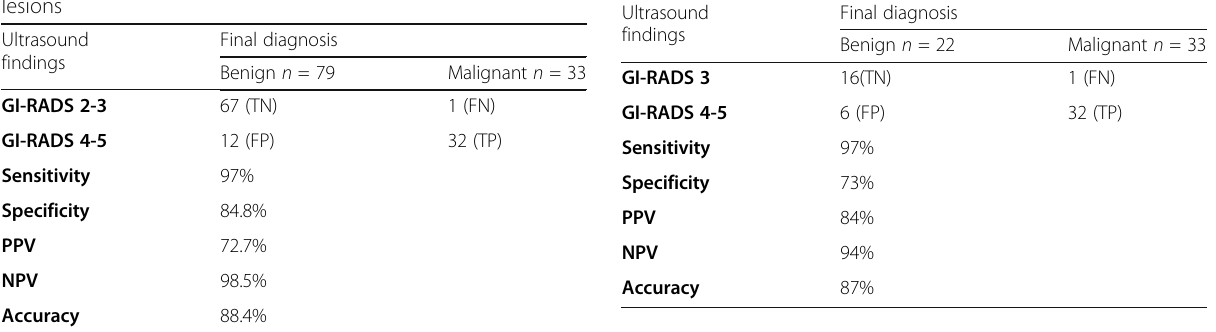
Table 4 The overall diagnostic performance of GI-RADS classification in diagnosis of the detected (112 lesions) ovarian